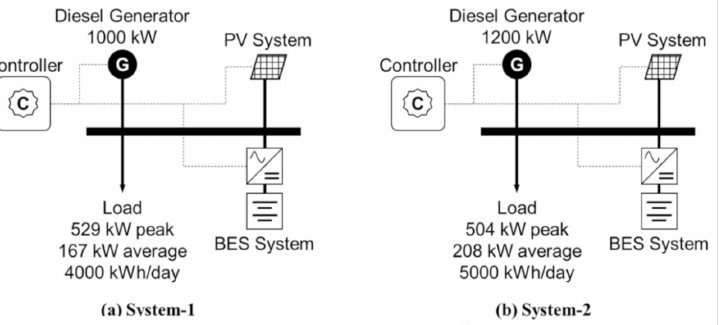
Figure 10. Configuration of the hybrid power generation system. Both systems have typical configu- rations but with different characteristics. System-1 with a higher peak load had a lower generator capacity than System-2.